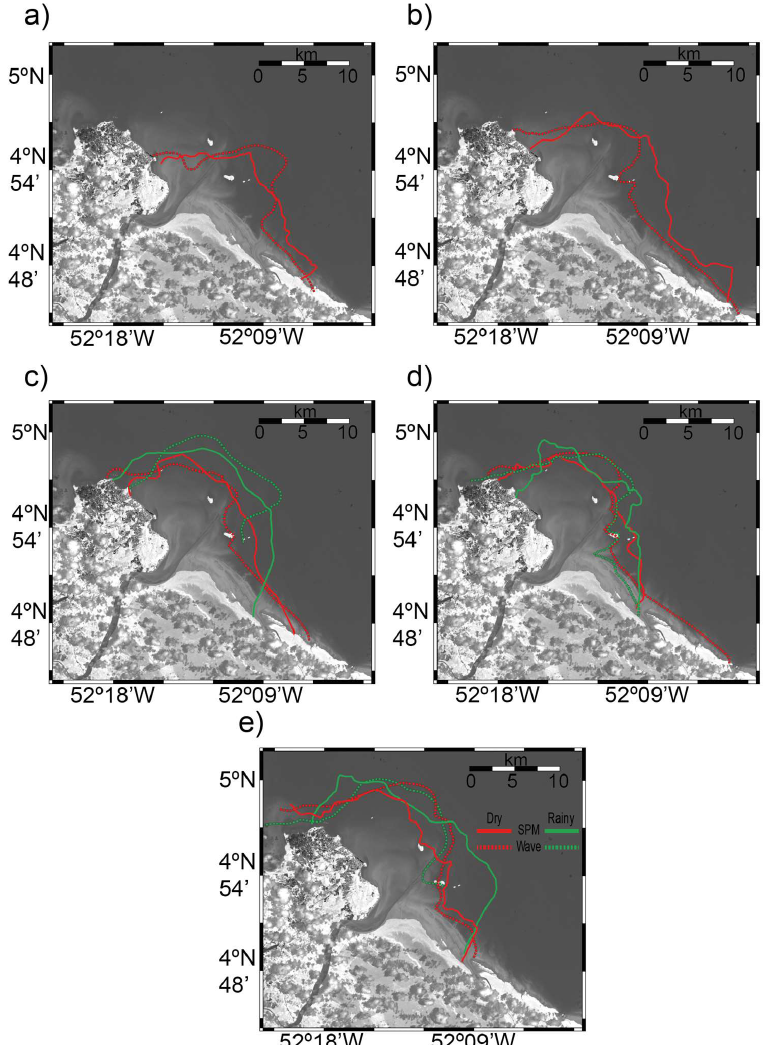
Figure 4. Migration of the mud bank in front of Cayenne Island. Estimation of the footprint of the subtidal part obtained with the SPM values method and the wave damping delimitation method (solid and dashed lines, respectively) for the dry and rainy season (red and blue, respectively). The entire Landsat 8-OLI period is covered (from 2013 to 2017 ( a – e )).